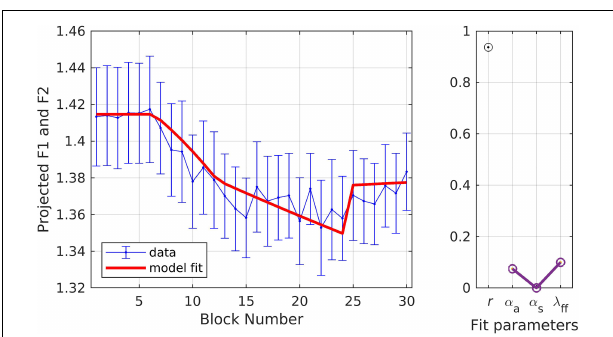
FIGURE 7 | Simulation 5: model fits of a dataset with perturbations applied to fundamental frequency in both shift-up and down directions; shift-up and down data are fit simultaneously (data from Abur et al., 2018). (Left) Mean and standard error of experimental data in blue; model fit in red. (Right) Fit quality and optimized parameter values ( r = correlation coefficient; α A = auditory feedback control gain, α s = somatosensory feedback control gain, and λ FF = learning